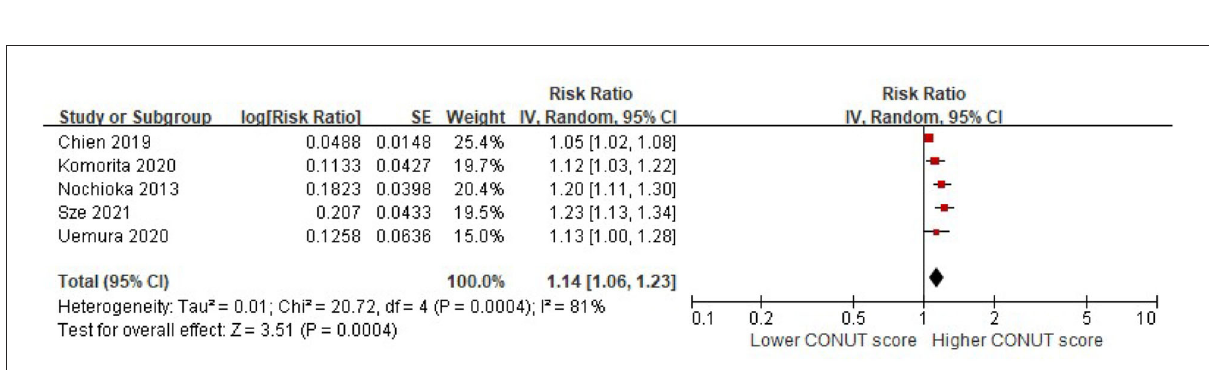
FIGURE5 A forest plot of comparison: The risk of MACEs in patients with HF associated with per-1 increase of the CONUT score. CONUT, controlling nutritional status; HF, heart failure; MACEs, major adverse cardiac events.